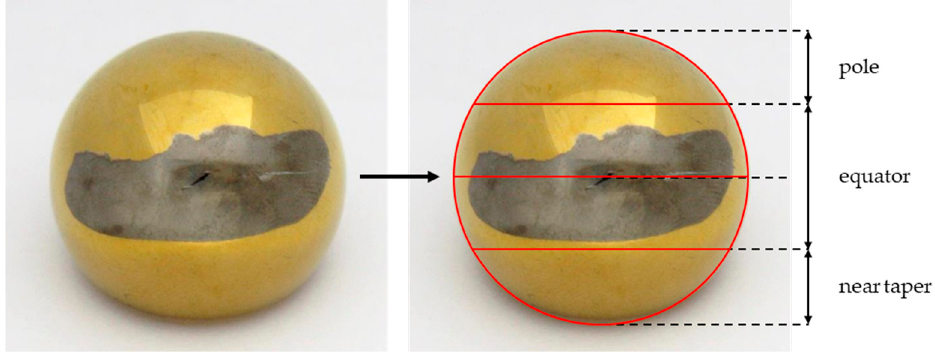
Figure 2. TiN-coated femoral head with metallic deposition in the equatorial area.